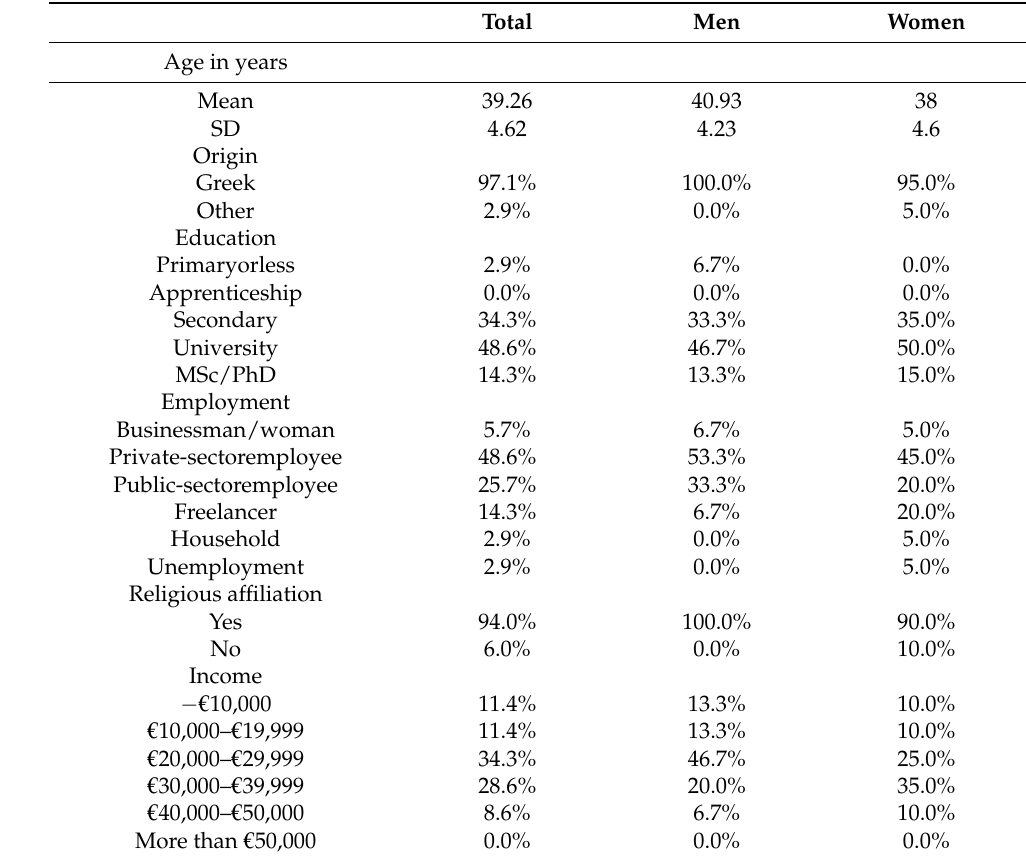
Table 5. Sociodemographic characteristics of the patients undergoing